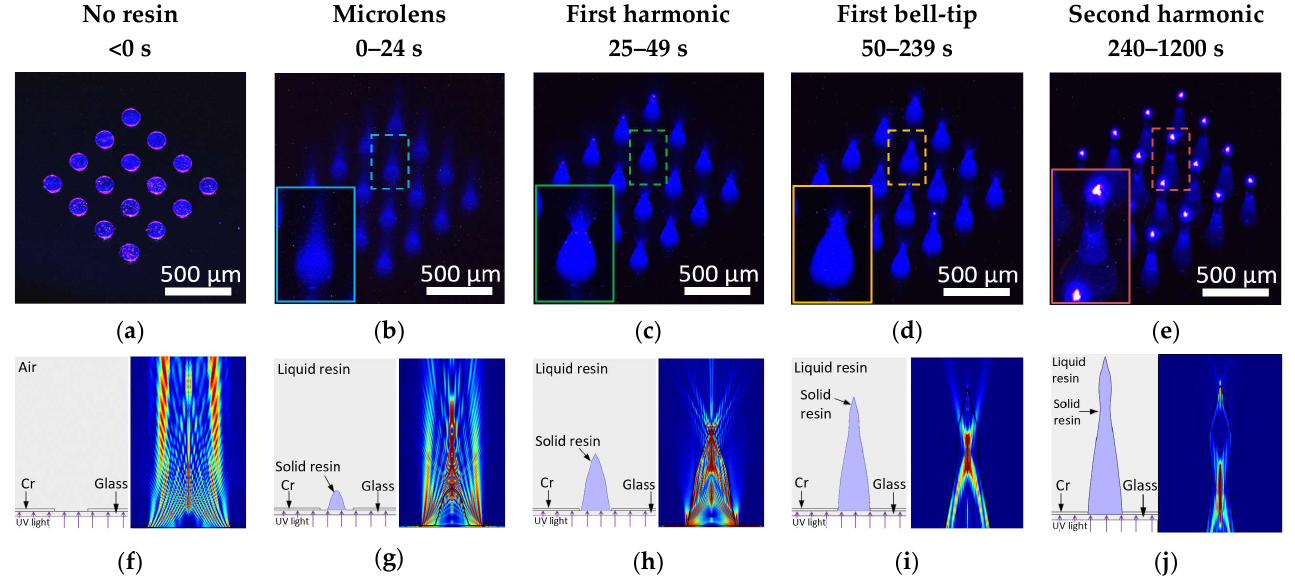
Figure 2. UV light propagation through the photomask before resin coating and during the four transition phases. ( a ) UV light propagation through the photomask patterns. ( b ) Forming microlens shape with focused light. ( c ) First harmonic shape as microneedle. ( d ) First bell-tip formed. ( e ) Second harmonic shape on top to the first harmonic shape. Simulation results of UV light propagation using COMSOL Multiphysics ® Software. ( f ) UV light propagation in air through a 150 µm slit. ( g ) UV light propagation in resin with presence of a microlens. ( h ) Diverging light propagation as light exited first harmonic. ( i ) UV light propagation during first bell-tip phase. ( j ) UV light propagation during second harmonic phase.